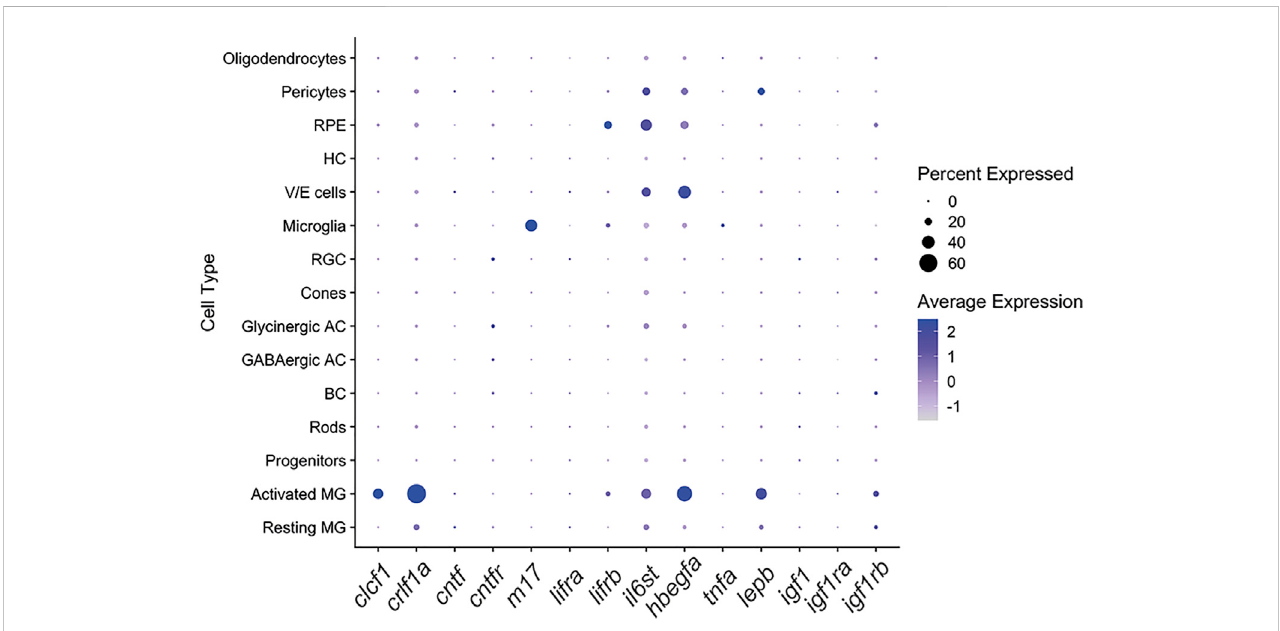
FIGURE 1 TheCNTFRligandsClcf1andCrlf1aareexpressedbyMüllergliawithinthezebra fi shretina.DotplotshowingexpressionoftheCNTFRligands clcf1,crlf1a and cntf, andCNTFRreceptorcomponents cntfr,lifrb and il6st inallretinalcelltypesinasingle-cellRNA-Seqdataset(Hoangetal.,2020).Expressionofother pro-proliferative factors is also shown. Cells are from combined whole retina samples of 0 h, 4 h, 10 h, 20 h and 36 h of light